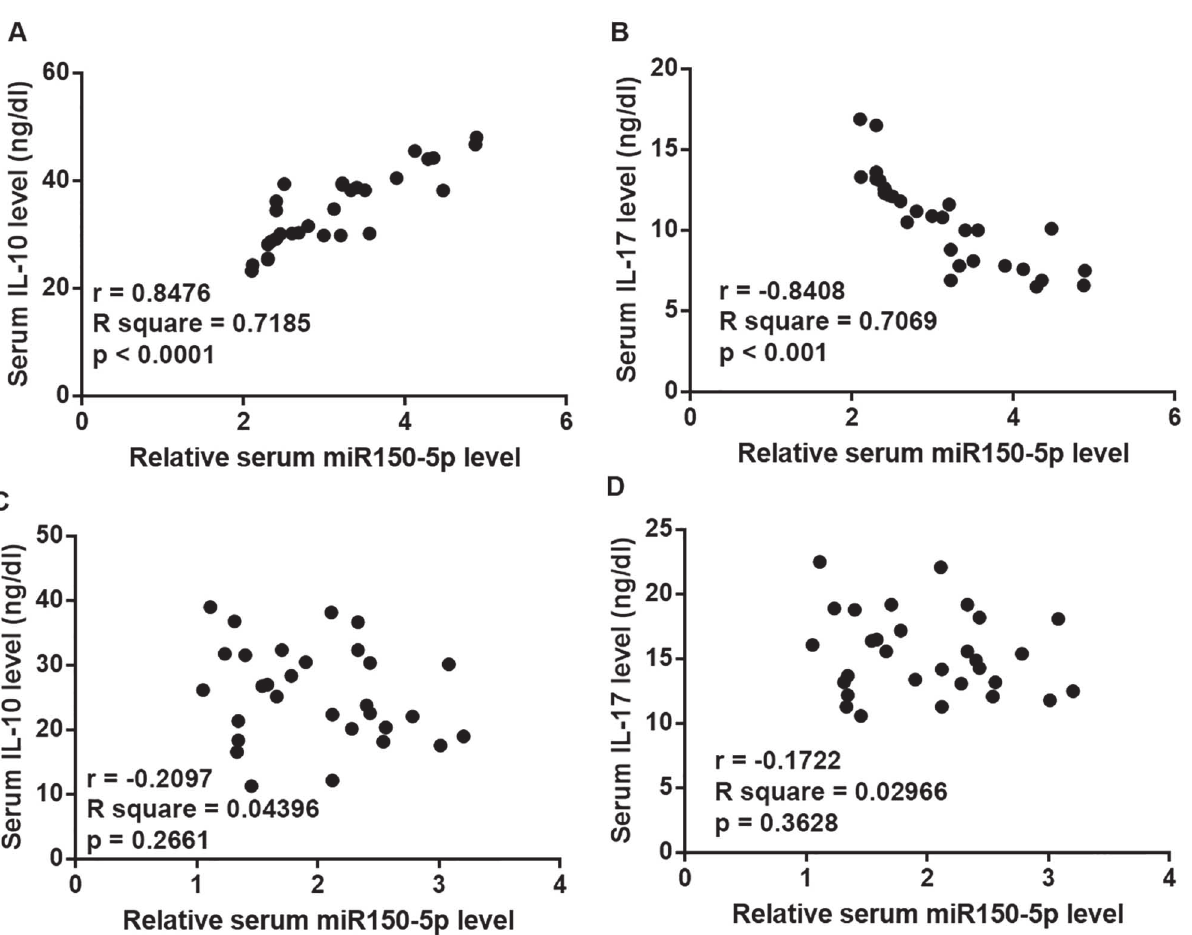
Fig. 3. Serum levels of miR150-5p were positively correlated with IL-10 and negatively correlated with IL-17. Correlation analyses revealed a positive correlation between serum miR150-5p and IL-10 (A) and a negative correlation between serum miR150-5p and IL-10 (B). But miR150-5p was not significantly correlated with IL-10 (C) and IL-10 (D) in healthy controls. Here R square >0.65 indicated a strong